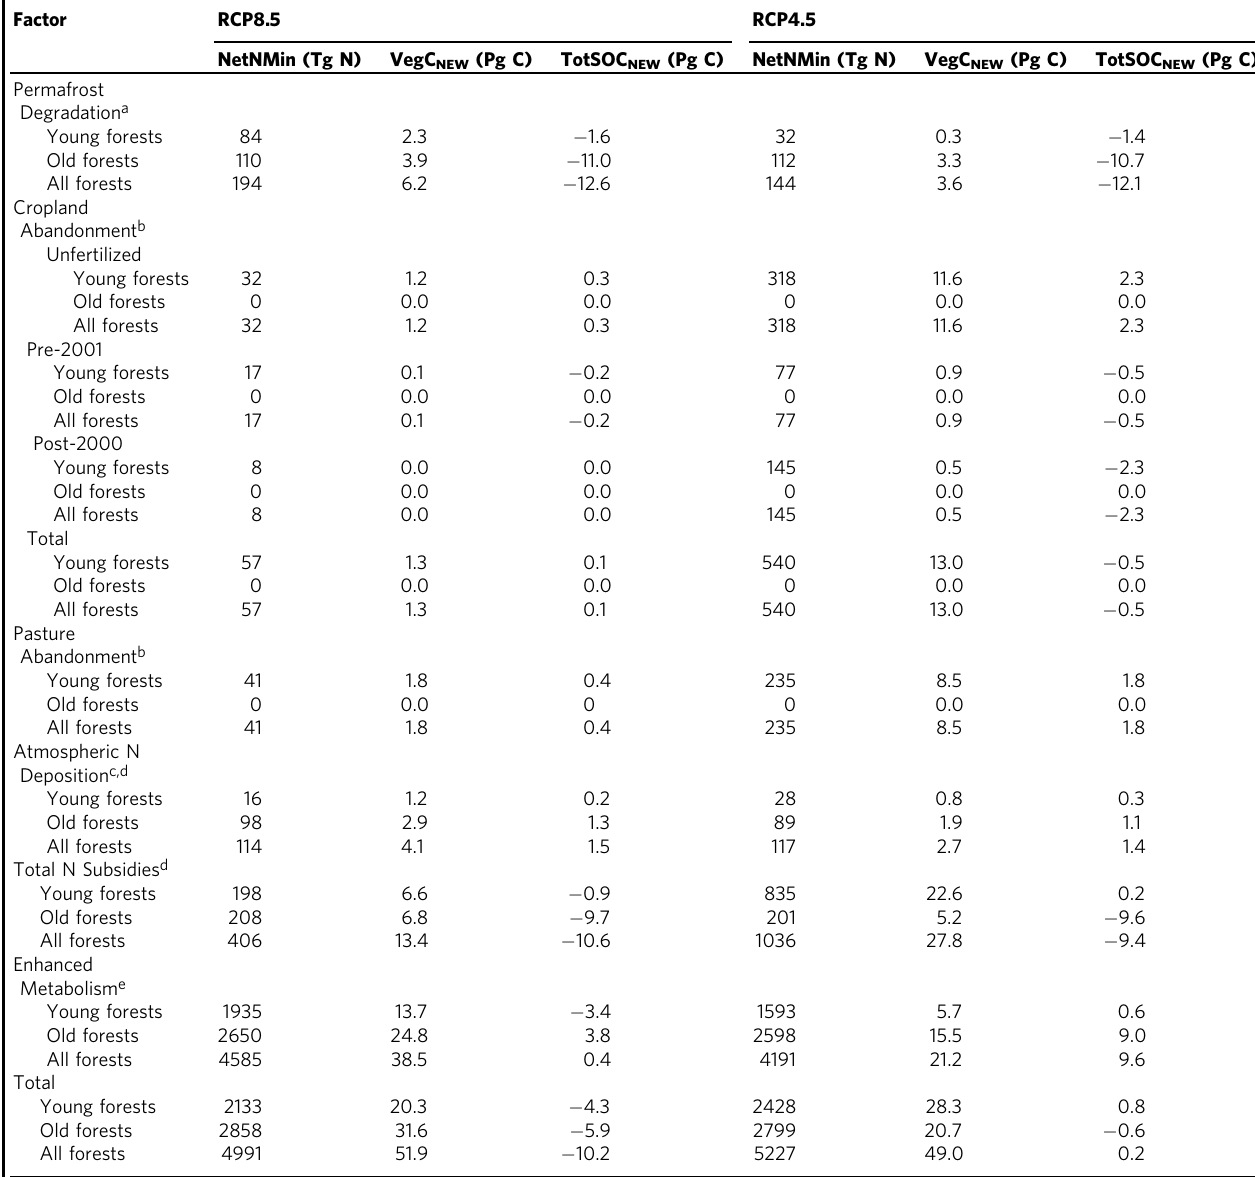
Table 1 Effect of N subsidies on cumulative net N mineralization (NetNMin), and C sequestration in forest vegetation (VegC NEW ) and soils (TotSOC NEW ) over the 21st